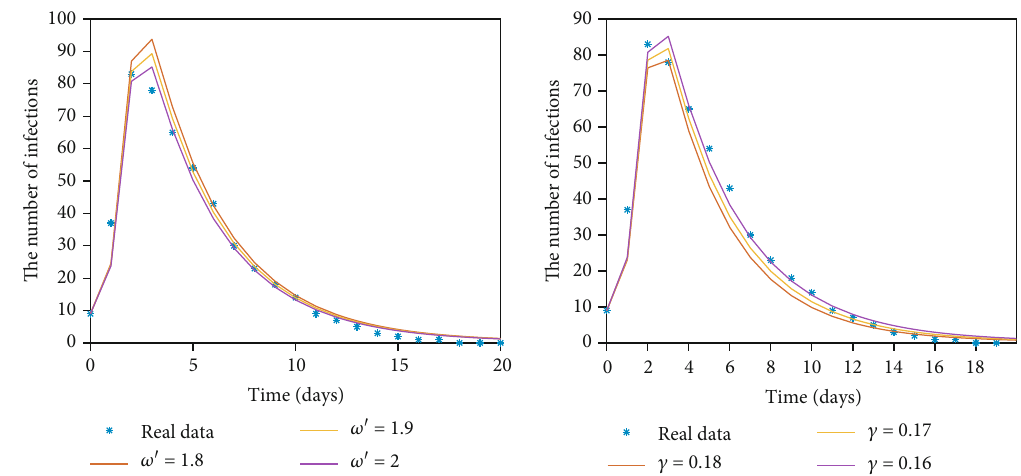
Figure 7: The in fl uences of ω ′ , γ on the quantity of infections I ð t Þ when the remaining parameters remain fi xed.